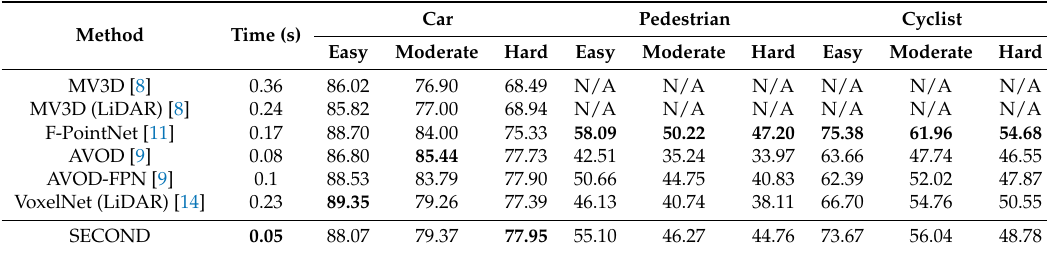
Car Pedestrian Cyclist Figure 5. Results of 3D detection on the KITTI test set. For better visualization, the 3D boxes detected using LiDAR are projected onto images from the left camera. Table 3. Bird’s eye view detection performance: Average precision (AP) (in %) for BEV boxes in the KITTI test set.